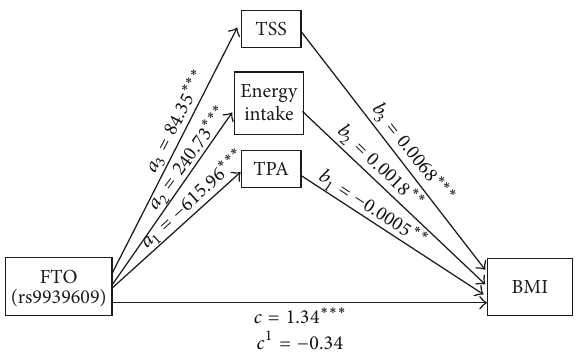
Figure 1: Multiple mediation models of the relationship between FTO rs9939609, TPA, energy intake, TSS, and BMI. (TPA, energy intake, and TSS are mediators). Standardized coefficients are presented and tested for significance with 95% confidence intervals calculated using the bias-corrected bootstrap method (5000 samples). a = standardized IV to Med coefficient, b = standardized Med to DV coefficient, c = standardized total effect (IV to DV), and c 1 = specific indirect effect (indirect path). ∗∗ 𝑝 < 0.01 ; ∗∗∗ 𝑝 < 0.001 . BMI: body mass index, TPA: total physical activity, TSS: time spent sitting, IV: independent variable, DV: dependent variable, and Med: